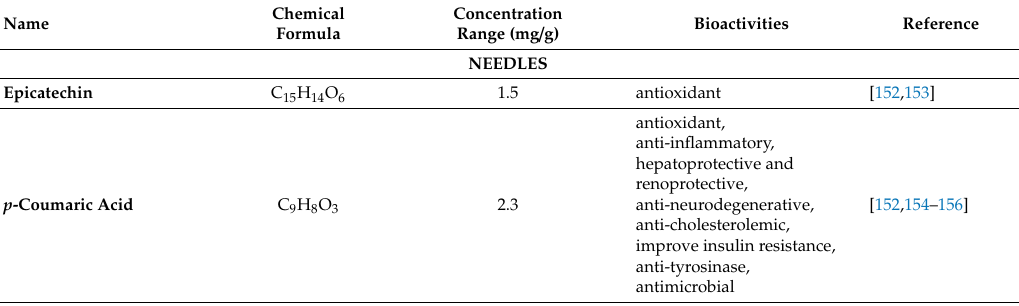
Table 3. Individual phenolic compounds found in pine by-products and their reported